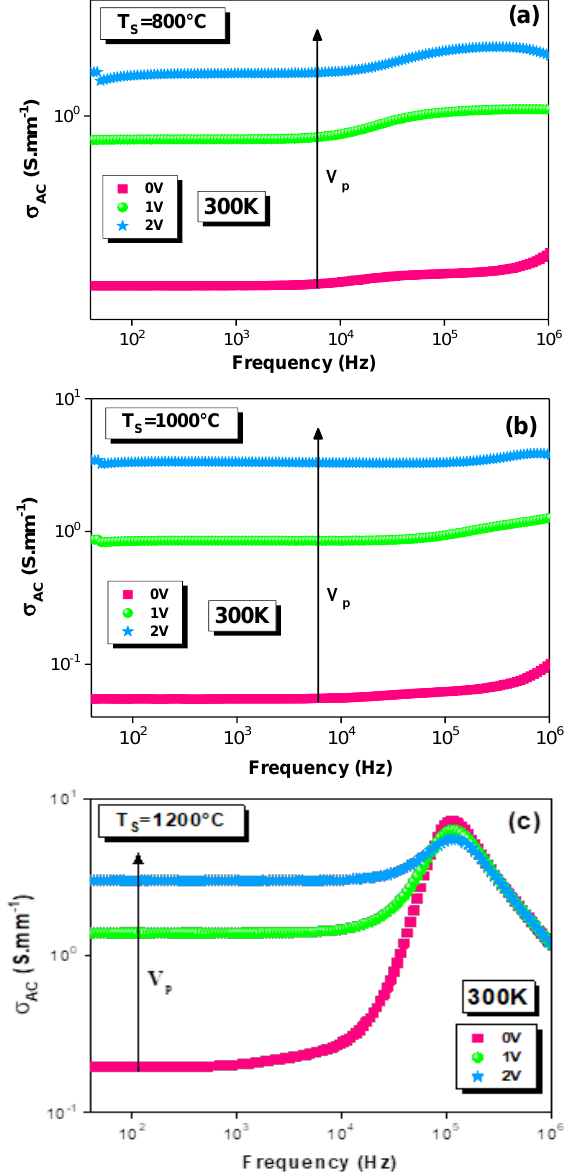
Figure 4. Frequency dependences of the electrical conductivity (σ) of the La0.9Sr0.1MnO 3 material sintered at ( a ) 800, ( b ) 1000 and ( c ) 1200 °C at room temperature under electrical polarization with an applied DC biases of Vp = 0, 1 and 2 V.